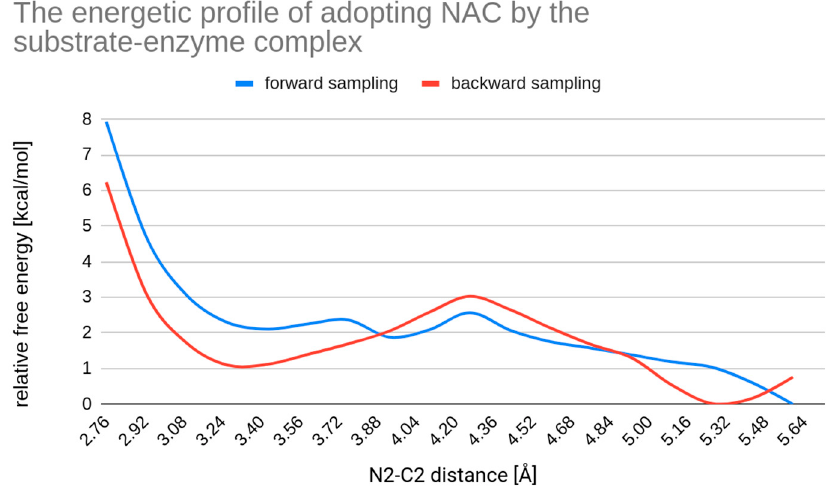
Figure 5. The free energy changes (PMF profile) for the C2-N2 distance: forward (from 5.7 to 2.7 Å) ( blue ) and backwards (from 2.7 to 5.7 Å) ( red ).